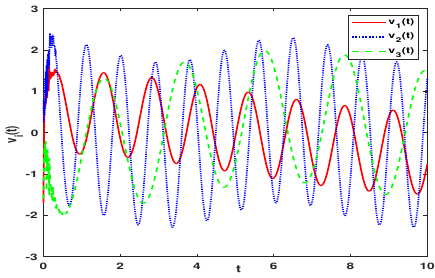
Figure 16. The recovered signals v i ( t ) .